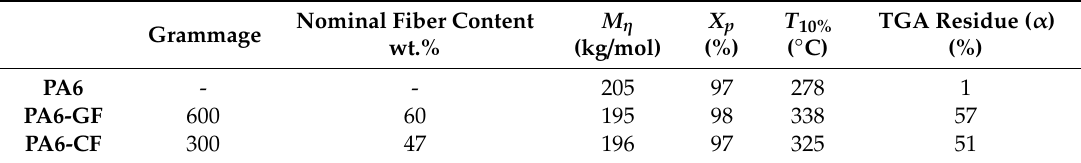
Table 1. Properties of neat PA6 and the fiber composites prepared in this work obtained by TGA and dilute solution viscometry. Grammage